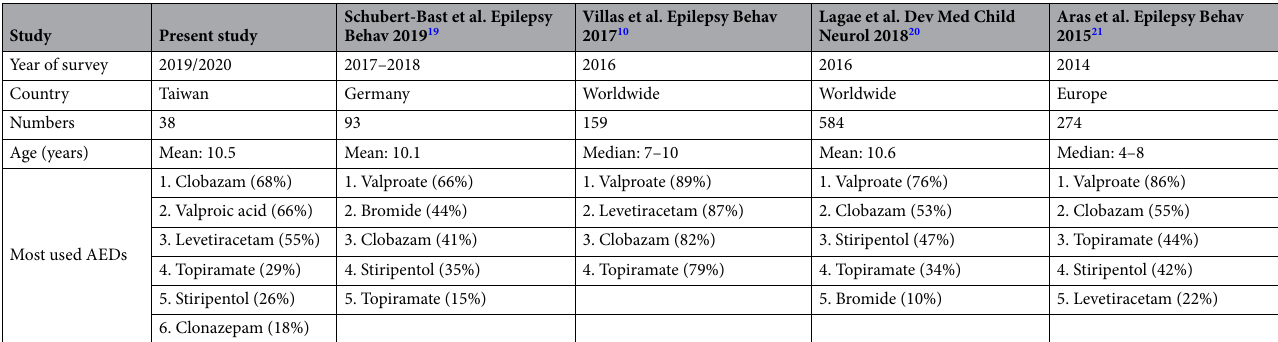
Table 4. Review of real-world evidence on the medicine utilization of patients with DS in the literature. AED antiepileptic